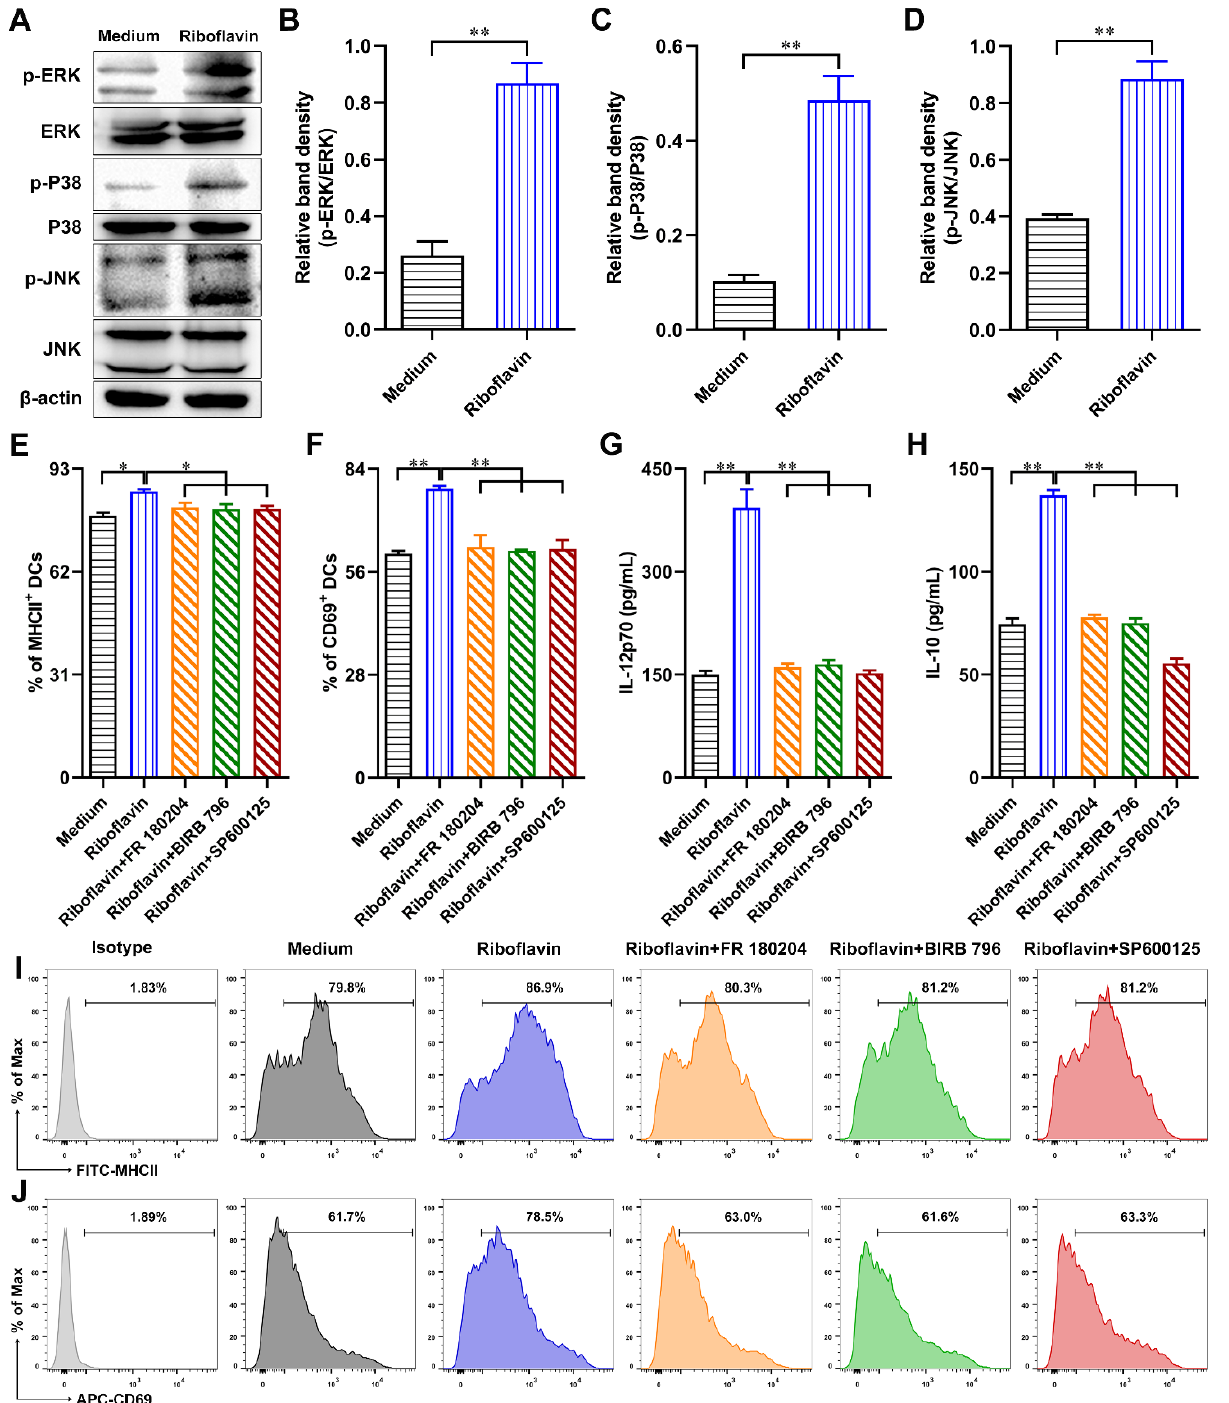
Figure 8. Riboflavin promotes DC maturation via the MAPK pathway. ( A – D ) DCs were incubated with riboflavin (40 μ M) for 1 h, and then the expressions of p-ERK, ERK, p-P38, P38, p-JNK, JNK, and β -actin were detected by Western blot. ( E – J ) DCs were incubated with FR 180204 (ERK inhibitor, 10 μ M), BIRB 796 (P38 MAPK inhibitor, 10 μ M), or SP600125 (JNK inhibitor, 10 μ M) for 2 h, followed by riboflavin for 24 h. The expressions of MHCII ( E , I ) and CD69 ( F ,J) in DCs were detected via FCM, and then the secretions of IL-12p70 ( G ) and IL-10 ( H ) in the supernatant were detected by ELISA. Results are from one representative experiment out of three performed. All of the data are presented as the mean ± SD. Statistical significance was assessed by unpaired Student’s two-sided t -tests or one-way ANOVA analysis to compare the results between the two groups or different groups, respectively; * p < 0.05, ** p < 0.01.